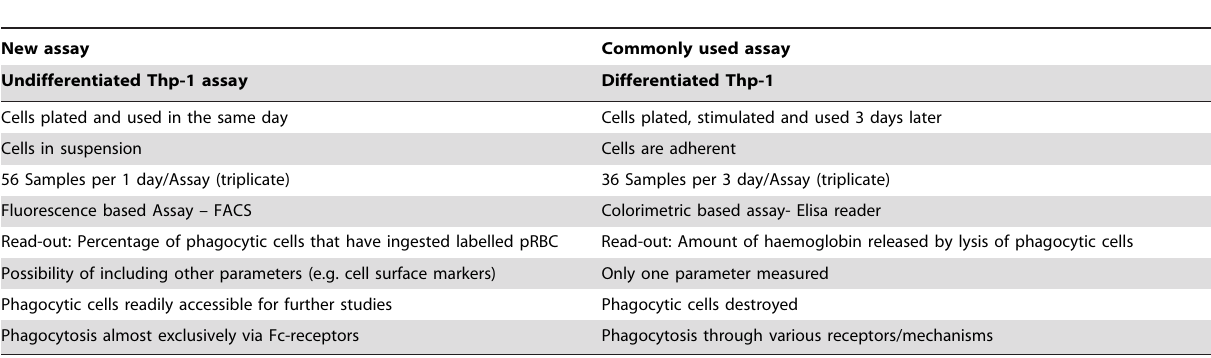
Table 1. Main differences between new phagocytosis method and the common method used.